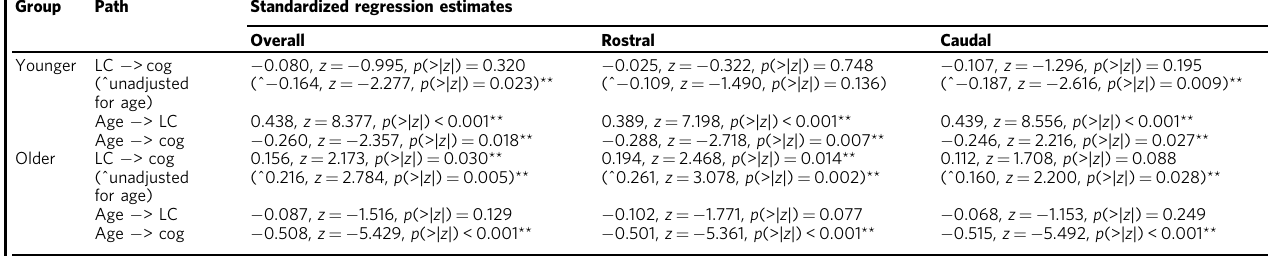
Table 2 Unidimensional, age-adjusted, multi-group